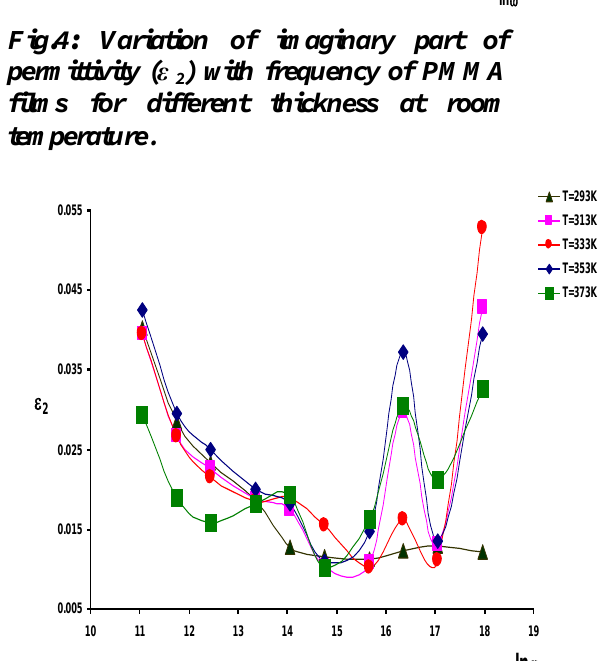
Fig.5: Variation of imaginary part of permittivity (ε ) with frequency of PMMA 2 films for different temperatures